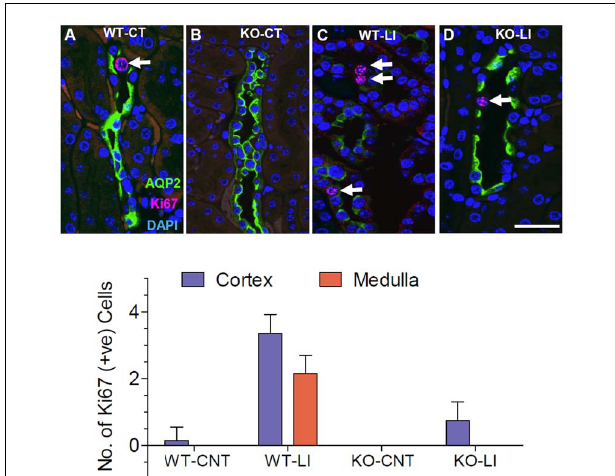
FIGURE 13 | Representative profiles of immunofluorescence analysis of cell proliferation in the collecting ducts of wild type (WT) and knockout (KO) mice fed control (CT) or lithium-added (LI) diets for 5 months. (A–D) Representative images from the renal cortex. AQP2 immunolabeling (green) was used to identify the principal cells of the collecting duct. Sections were co-stained for the Ki67 (red) nuclear cell marker for proliferation. Nuclei are stained with DAPI (blue). Note the significantly increased number of Ki67+ cells (arrows) in lithium-treated WT mice, and the diminished AQP2 immunofluorescence in response to Li-treatment in WT, but not in KO mice. Bar is 20 µ m. Bottom panel: Graphical representation of the statistical summary of the density (% of all CD cells in full frame) of Ki67+ cells in cortical and medullary collecting ducts in WT, or KO mice fed control or lithium-added diets ( n = 4–5 each